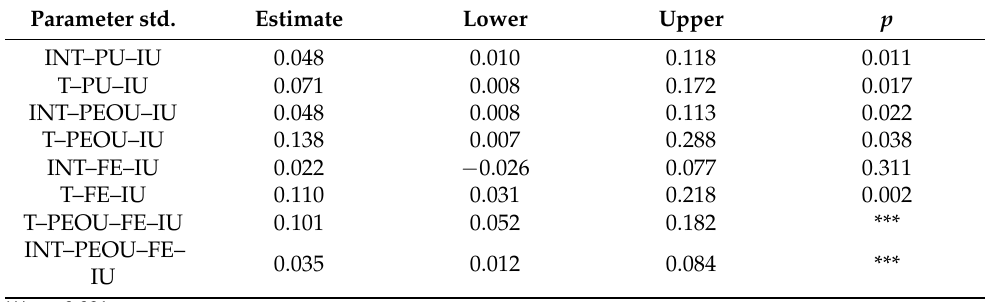
Table 8. Mediating effect